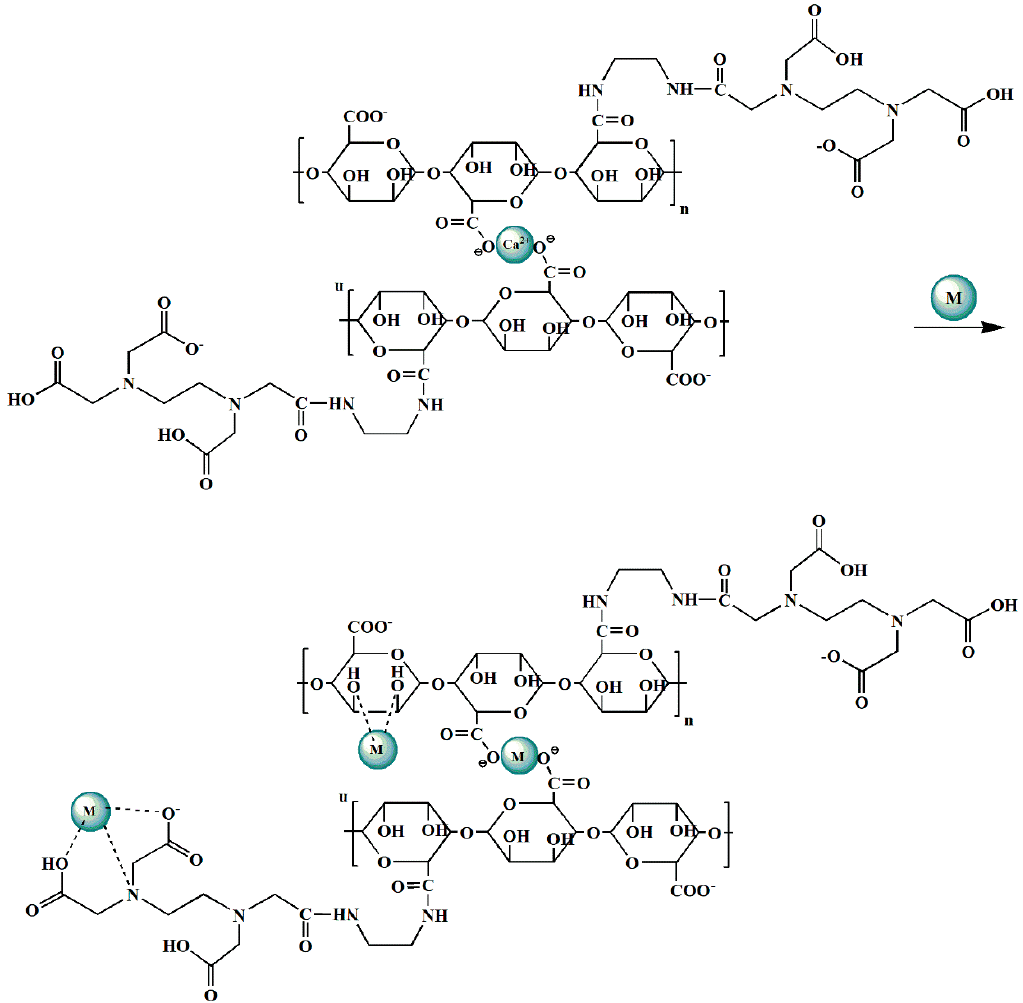
Figure 11. Plausible adsorption mechanism of Alg-EDTA combined with heavy metal ions. M represents heavy metal ions such as Cd 2+ , Pb 2+ , Cu 2+ , etc.